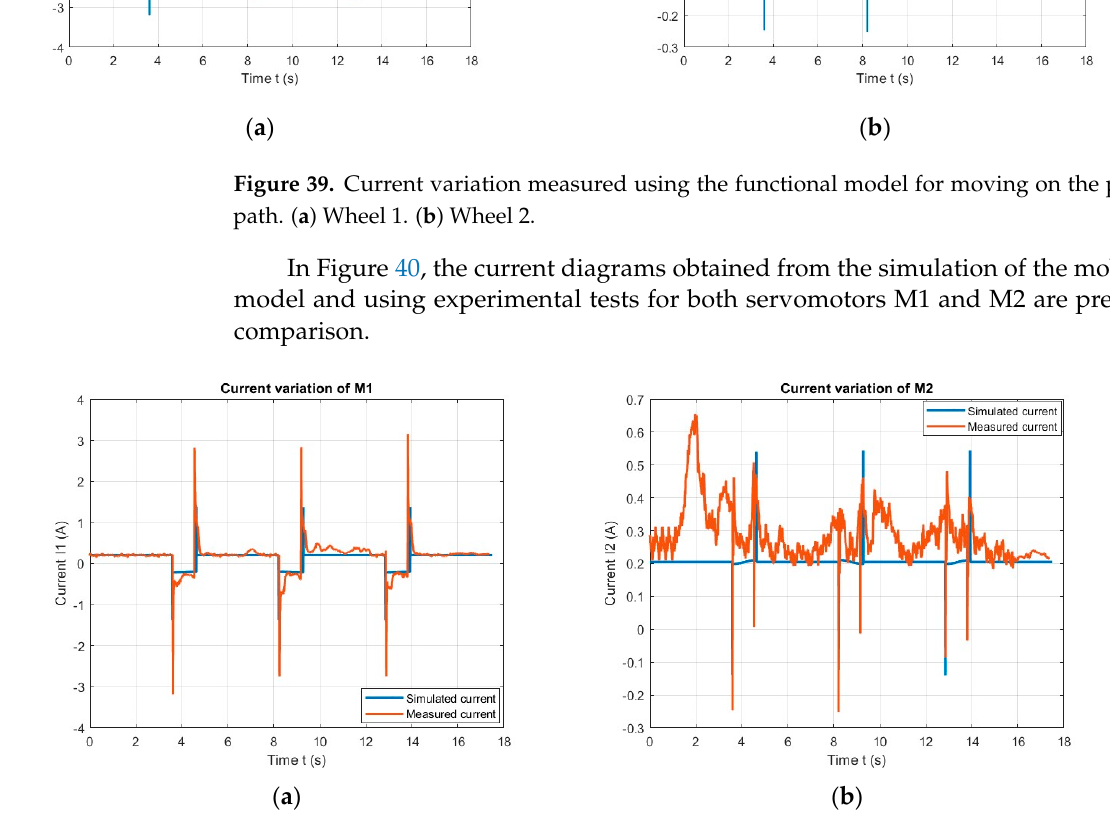
Table 10. Comparison between simulated and measured current—data statistics for motor M1.